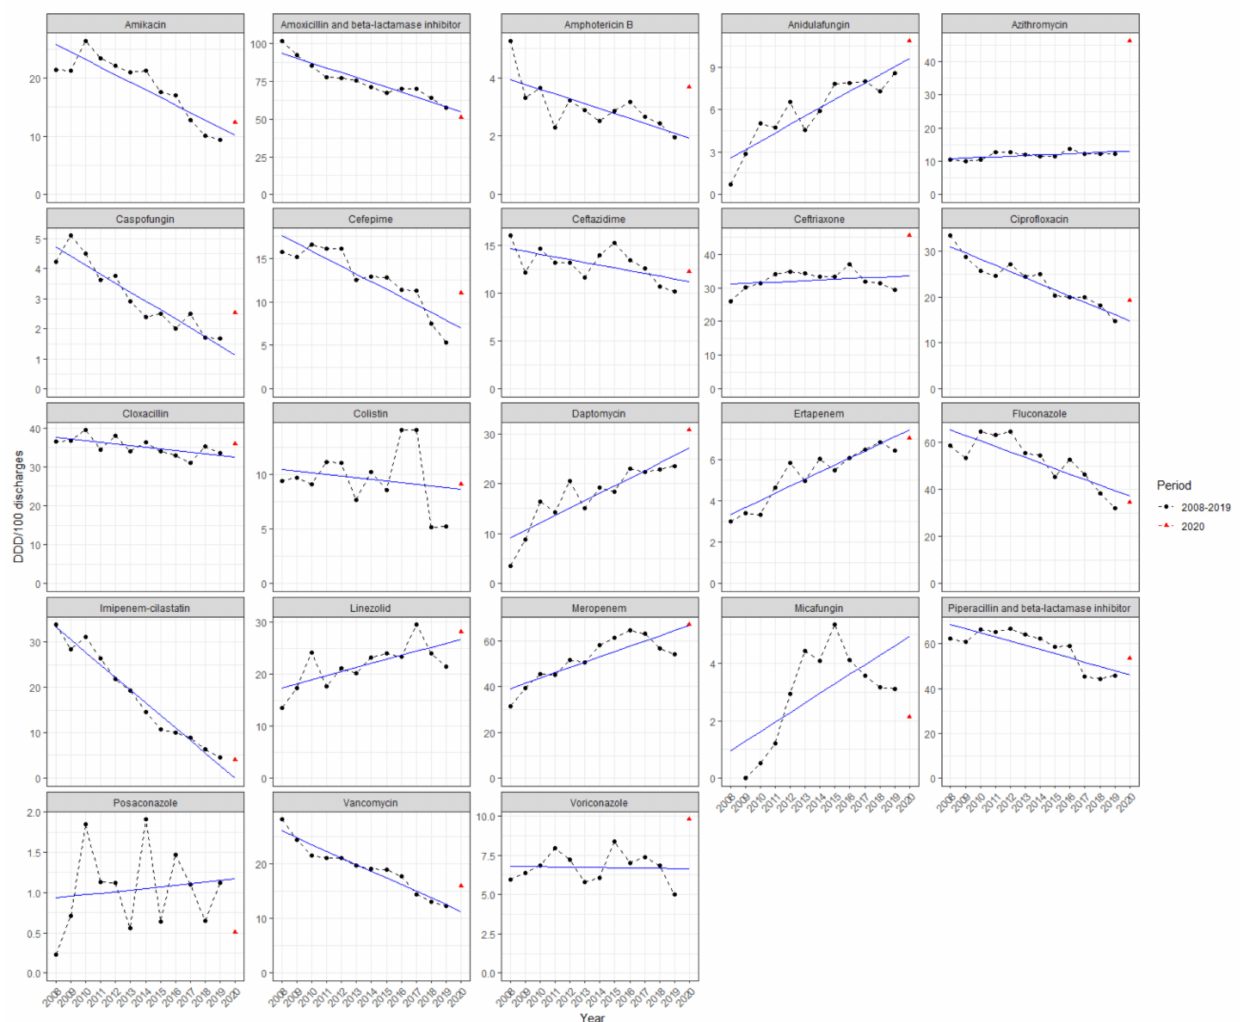
Figure 2. Evolution of antibiotic and antimycotic consumption in intensive care unit (ICU) services between 2008 and 2020, expressed in DDD/100 discharges. Non-COVID-19 period was considered from 2008 to 2019. DDD: Defined daily doses. Black circles: Antimicrobial consumption data for every year. Blue line: Antimicrobial consumption trend based on data from 2008 to 2019, and projected until 2020. Red triangle: Observed 2020